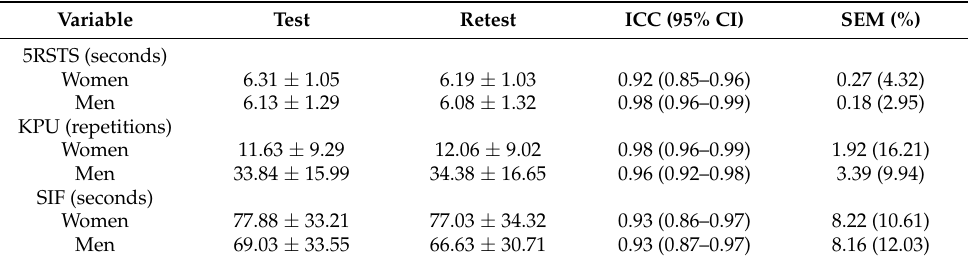
Table 2. Test–retest reliability in women ( n = 32) and men ( n = 32).